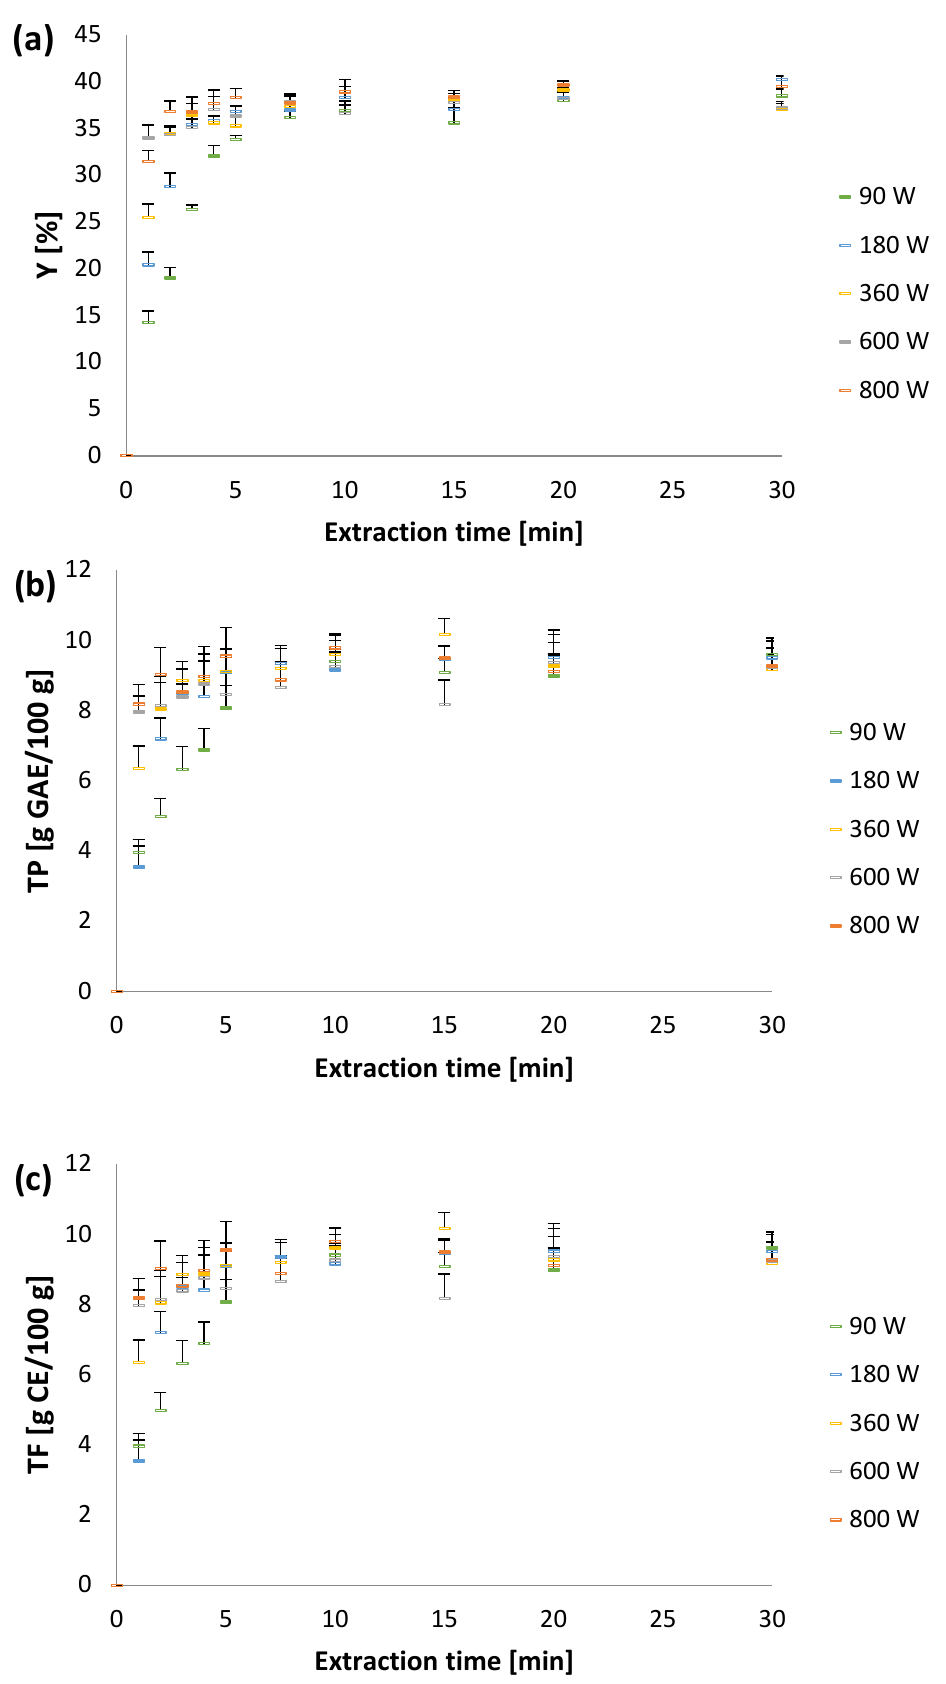
Figure 2. Experimentally observed values for: ( a ) Y, ( b ) TP, and ( c ) TF vs. extraction time.